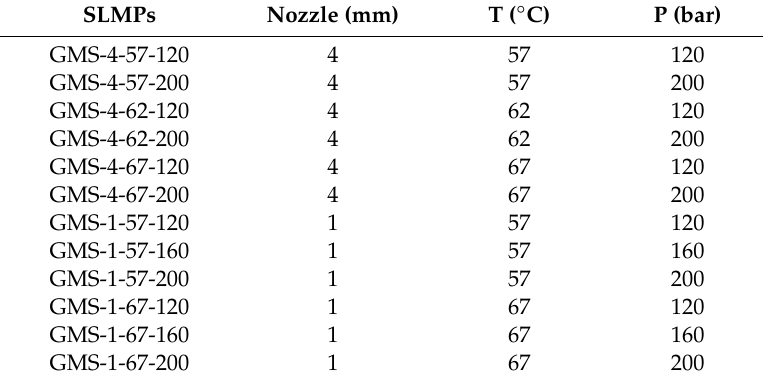
Table 3. Nozzle diameters and processing temperatures (T) and pressures (P) tested for the preparation of SLMPs of GMS using the PGSS ®